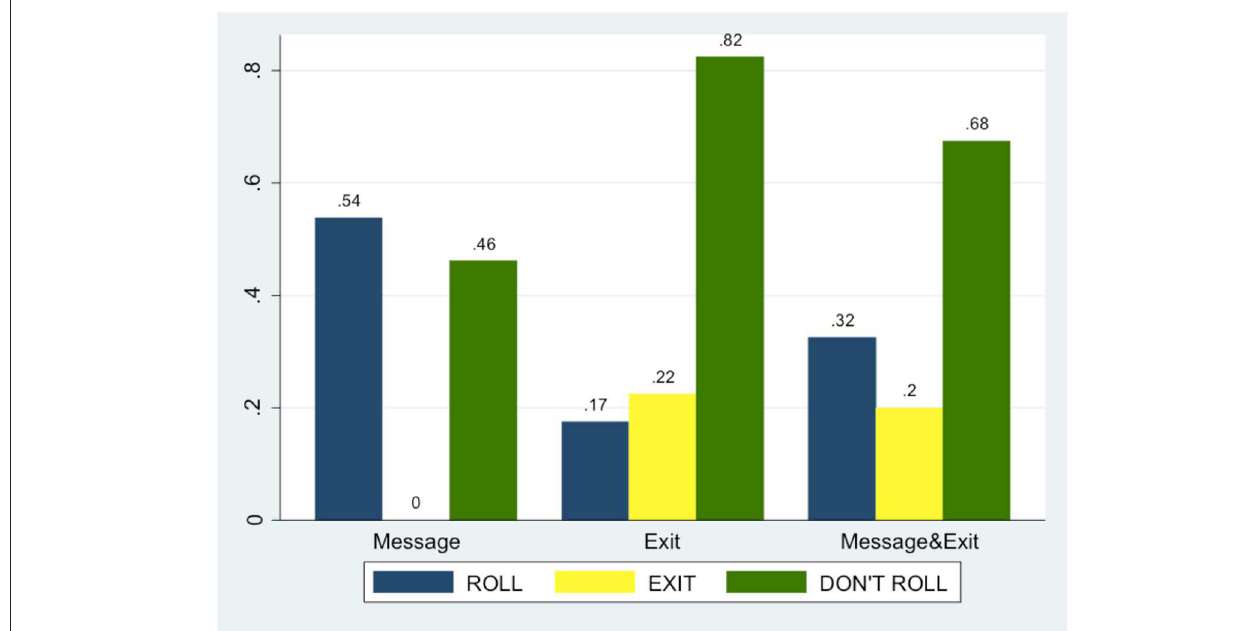
FIGURE 6 | Bs’ choices in different treatments.